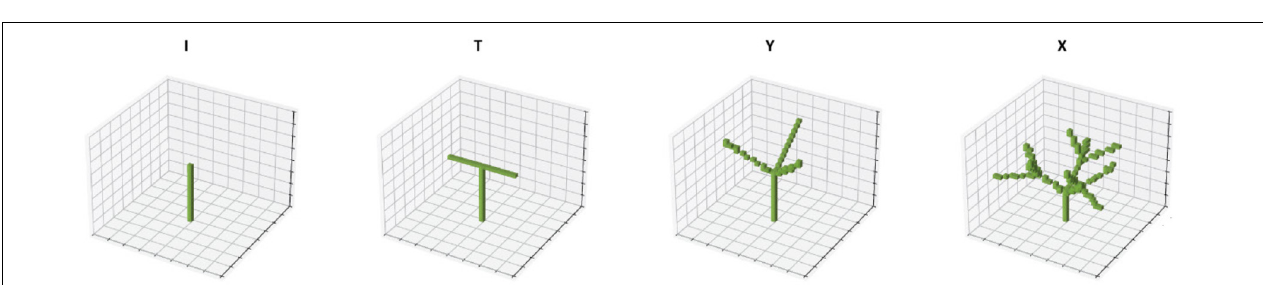
FIGURE 2 | Artificial habitat-structure dataset. Voxel representations of current artificial structures (Dataset 2): a non-habitat utility pole (I), two forms of utility poles enriched with perches (T and Y), and a 9-prong artificial structure analogous to a translocated dead tree (X).